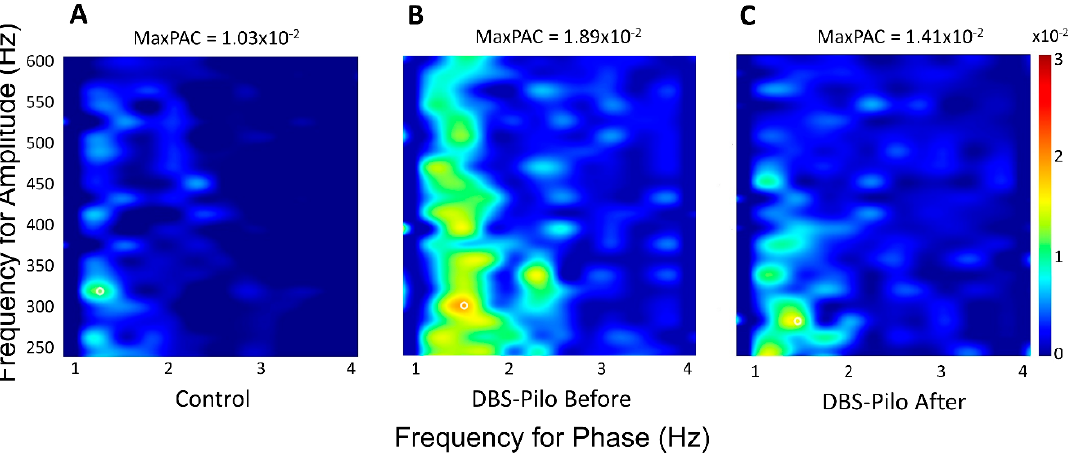
Figure 6. Representative comodulograms of phase-amplitude coupling (PAC) of individual animals showing the PAC strength between delta and fast-ripple frequency pairs. The coupling strength is color-coded (scale bar on the right). ( A ) The PAC comodulogram of the control animal is from a SHAM-Control rat. ( B ) The epileptic animals exhibited a stronger MaxPAC (white circle) which ( C ) was reduced after deep brain stimulation.